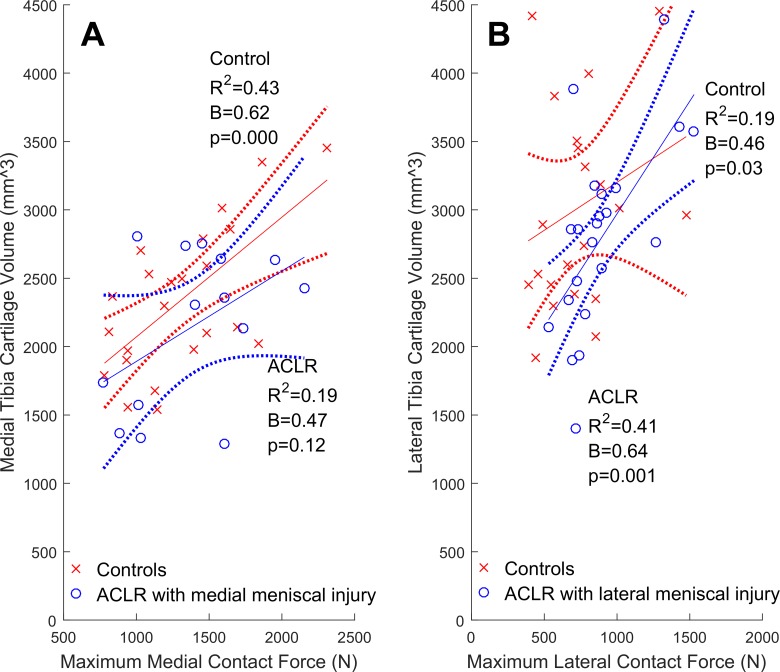
Tibial articular cartilage volumes (mm3) from the compartment that sustained a meniscal injury regressed onto maximum contact forces (N) with 95% confidence intervals (dotted lines). Shown are ACLR participants (circles) with (A) medial meniscal injury (n = 17) and (B) lateral meniscal injury (n = 25), while healthy controls (cross-hairs) are plotted for comparision. ACLR, anterior cruciate ligament reconstruction.